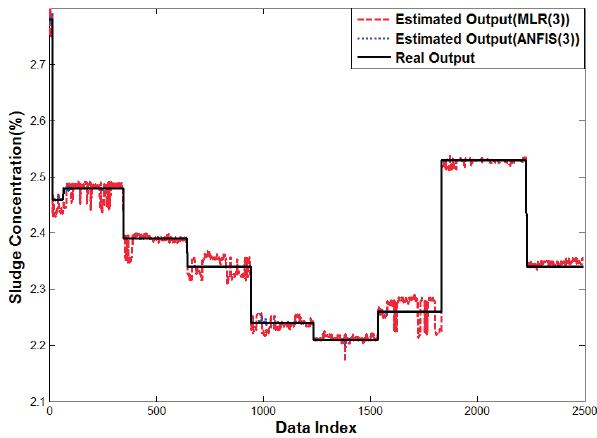
Figure 18. Performance curve of Methods 4 and